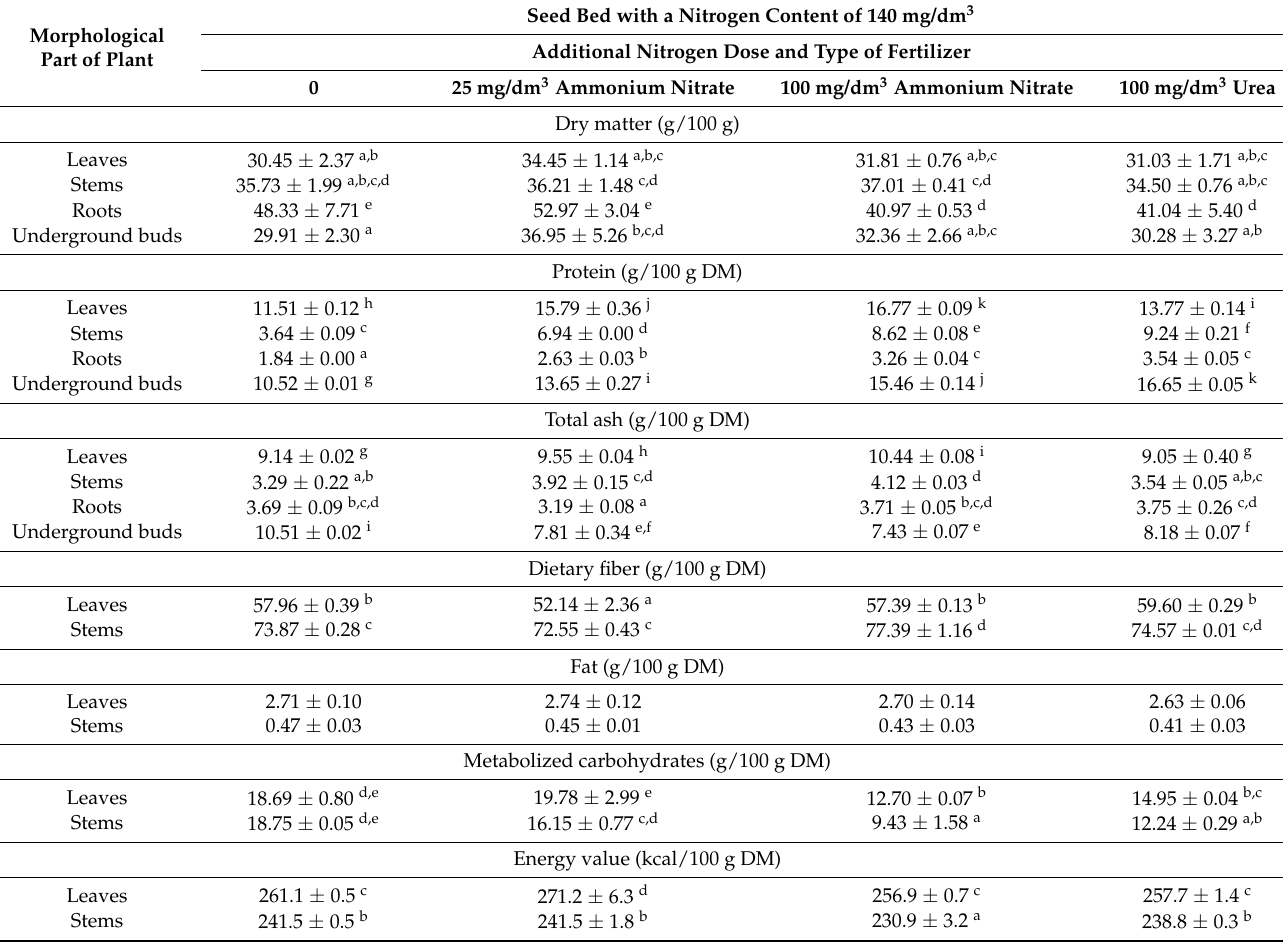
Table 1. The dry matter, nutrients, and energy value of selected morphological parts of fragrant agrimony Agrimonia procera Wallr. from experimental